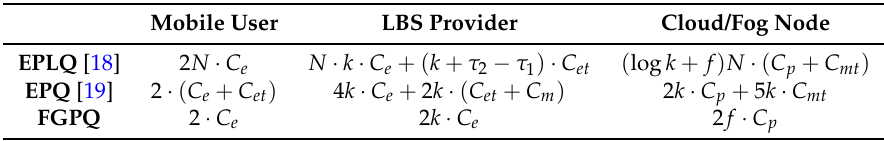
Table 1. Comparison of computational